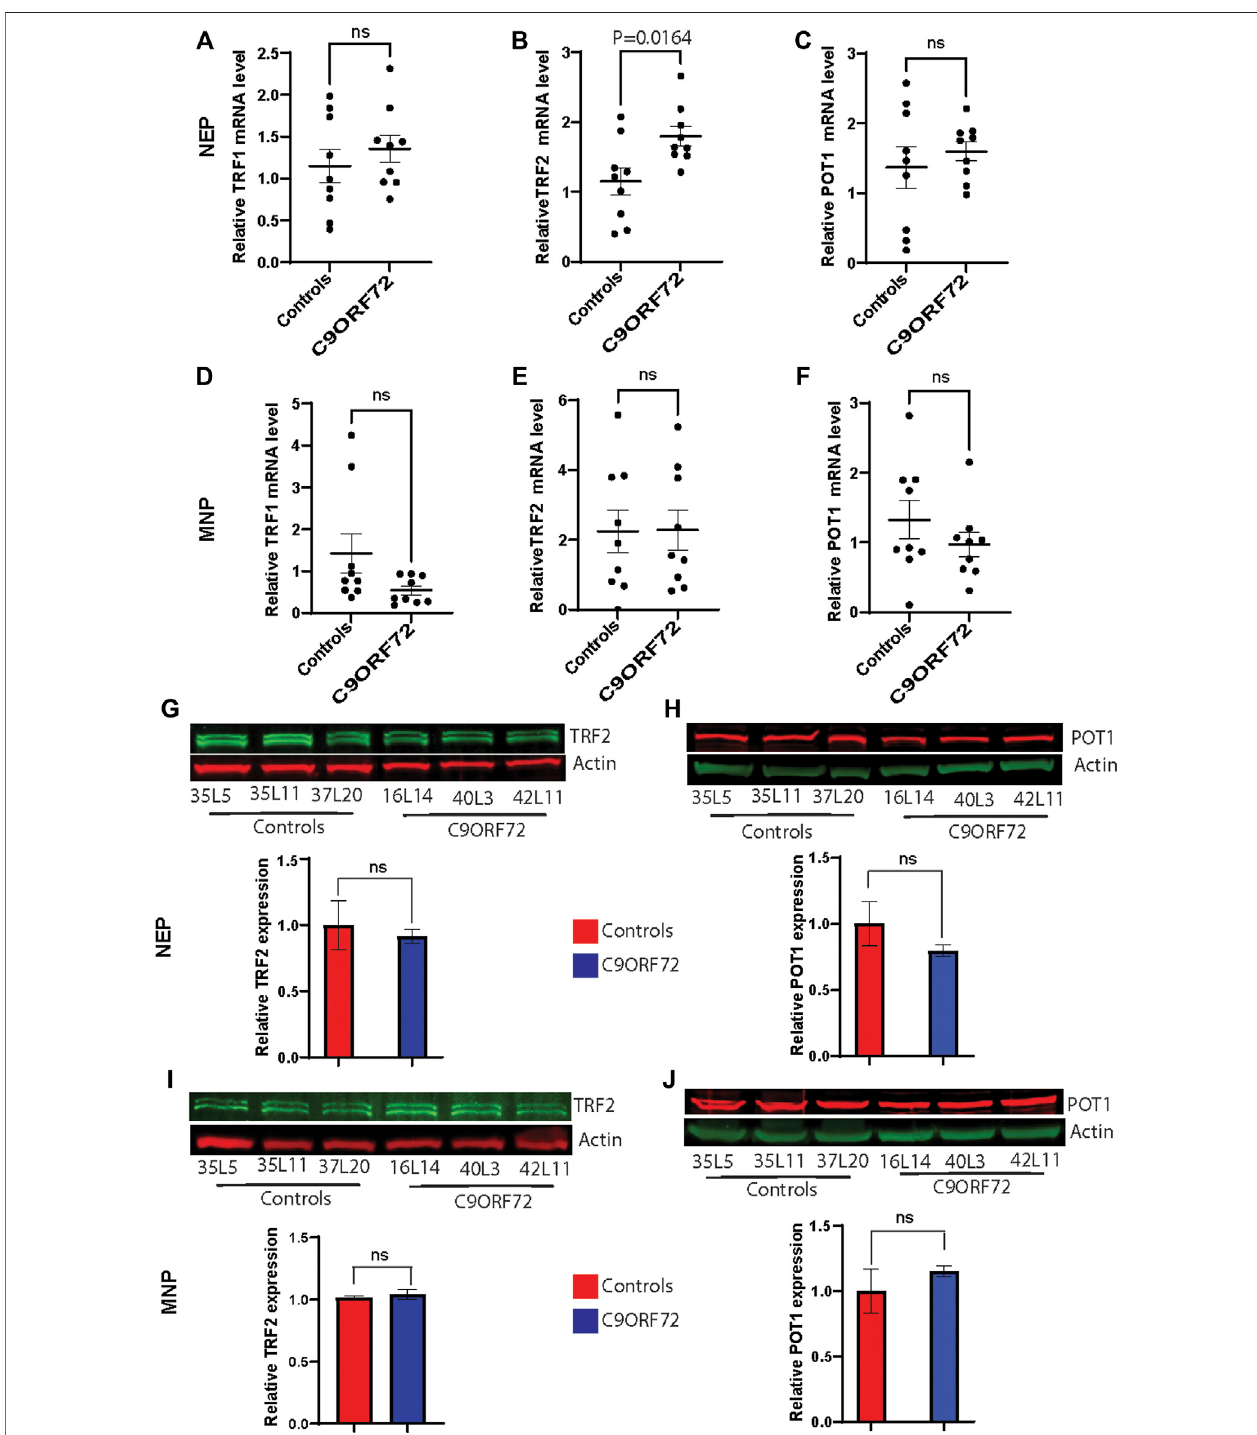
FIGURE 2 | Analysis of the expression of telomere maintenance genes during the differentiation of iPSCs to MNs from controls and C9ORF72 repeat expansion carriers. qPCRanalysistocompareexpression levels (A) TRF1, (B) TRF2and (C) POT1transcriptsinNEPand levelsof (D) TRF1, (E) TRF2and (F) POT1inMNPfrom3 control subjects and 3 C9ORF72 carriers, from 3 independent differentiations. Western blot analyses to compare protein levels of (G) TRF2 and (H) POT1 in NEP and protein levels of (I) TRF2 and (J) POT1 in MNP, from 3 controls and 3 C9ORF72 iPSC lines, Two-tailed t -test with Welch ’ s correction was applied. ns, not signi fi